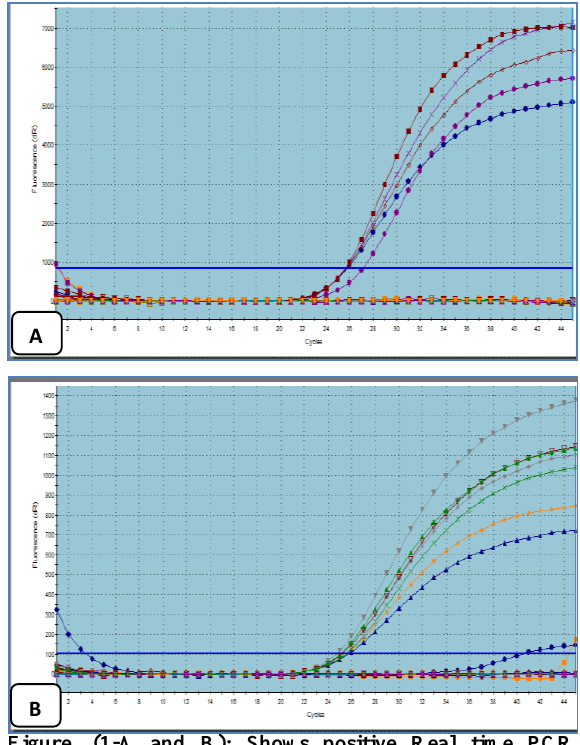
Table, 5: Shows the number and percentage of M. agalactiae on Real time PCR in milk samples.